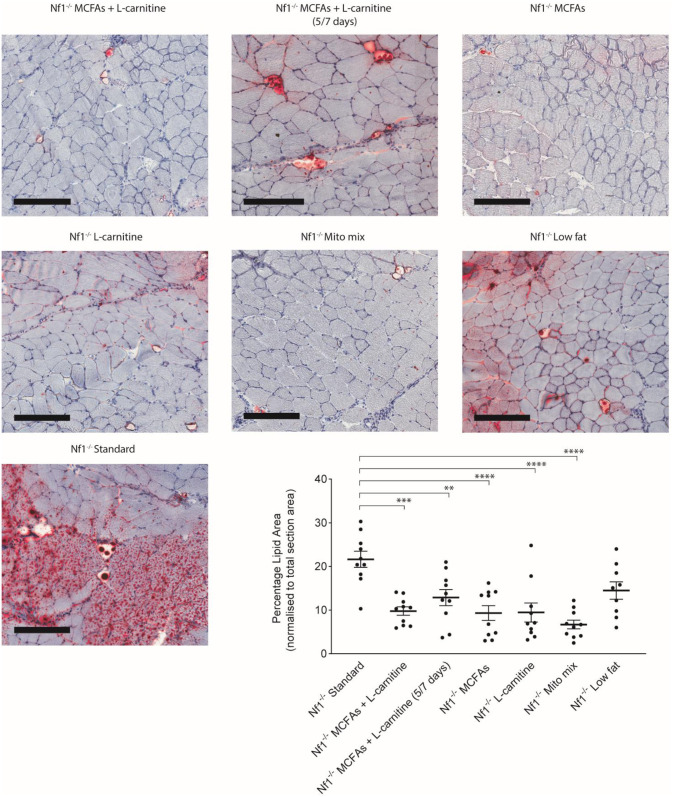
Dietary modifications in Nf1Prx1-/- mice rescue IMCL accumulation.Histological analysis using Oil Red O showed up to 69% reduction in IMCL accumulation. Scale bar; 200um at 10x magnification, n = 10. Data presented as group mean ± SEM. p-values were assessed by one way ANOVA. **p = 0.0083, ***p = 0.0001 and ****p<0.0001.